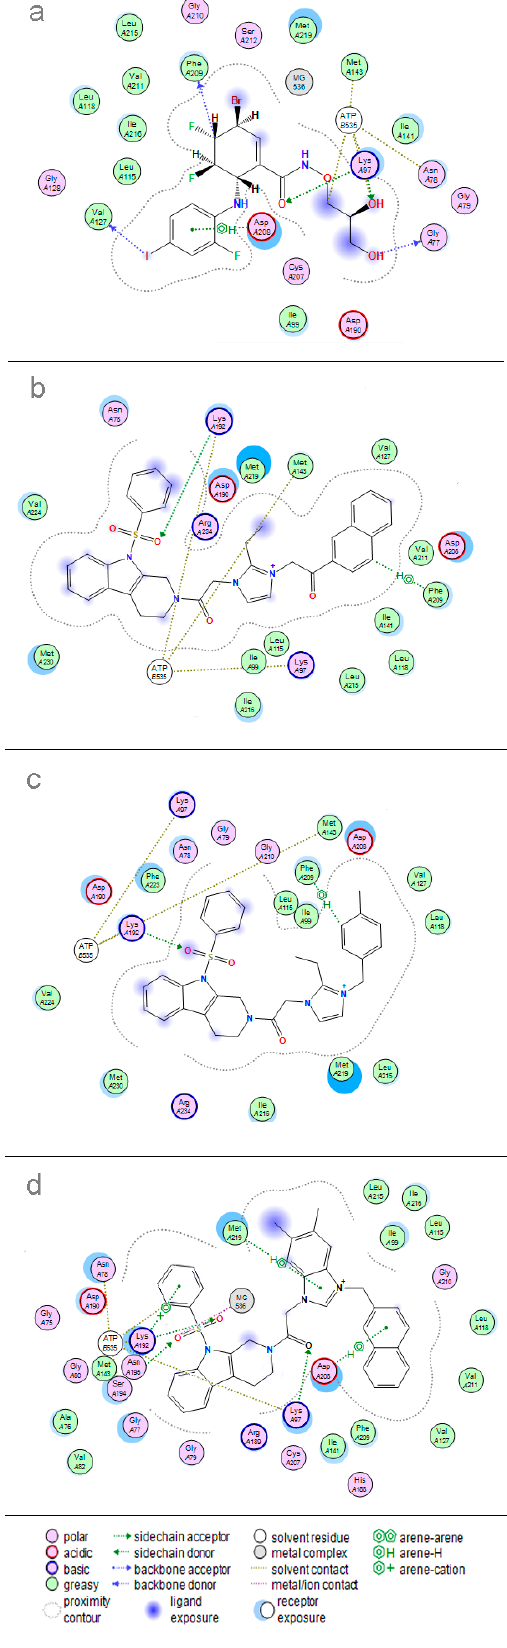
Figure 7. Molecular docking interactions of refametinib ( a ) and compounds 19 ( b ); 20 ( c ); and 35 ( d ).